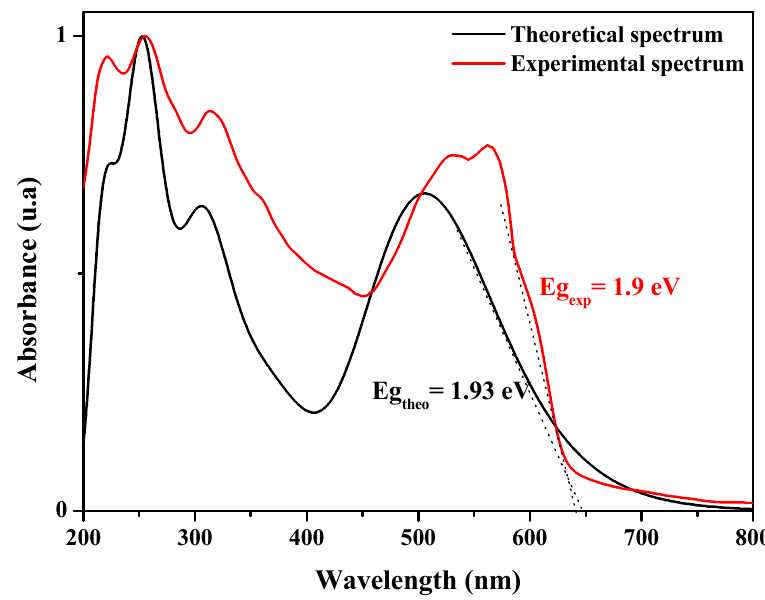
Figure 8. UV-vis absorption spectra of PVK-F8T2: experimental and theoretical.